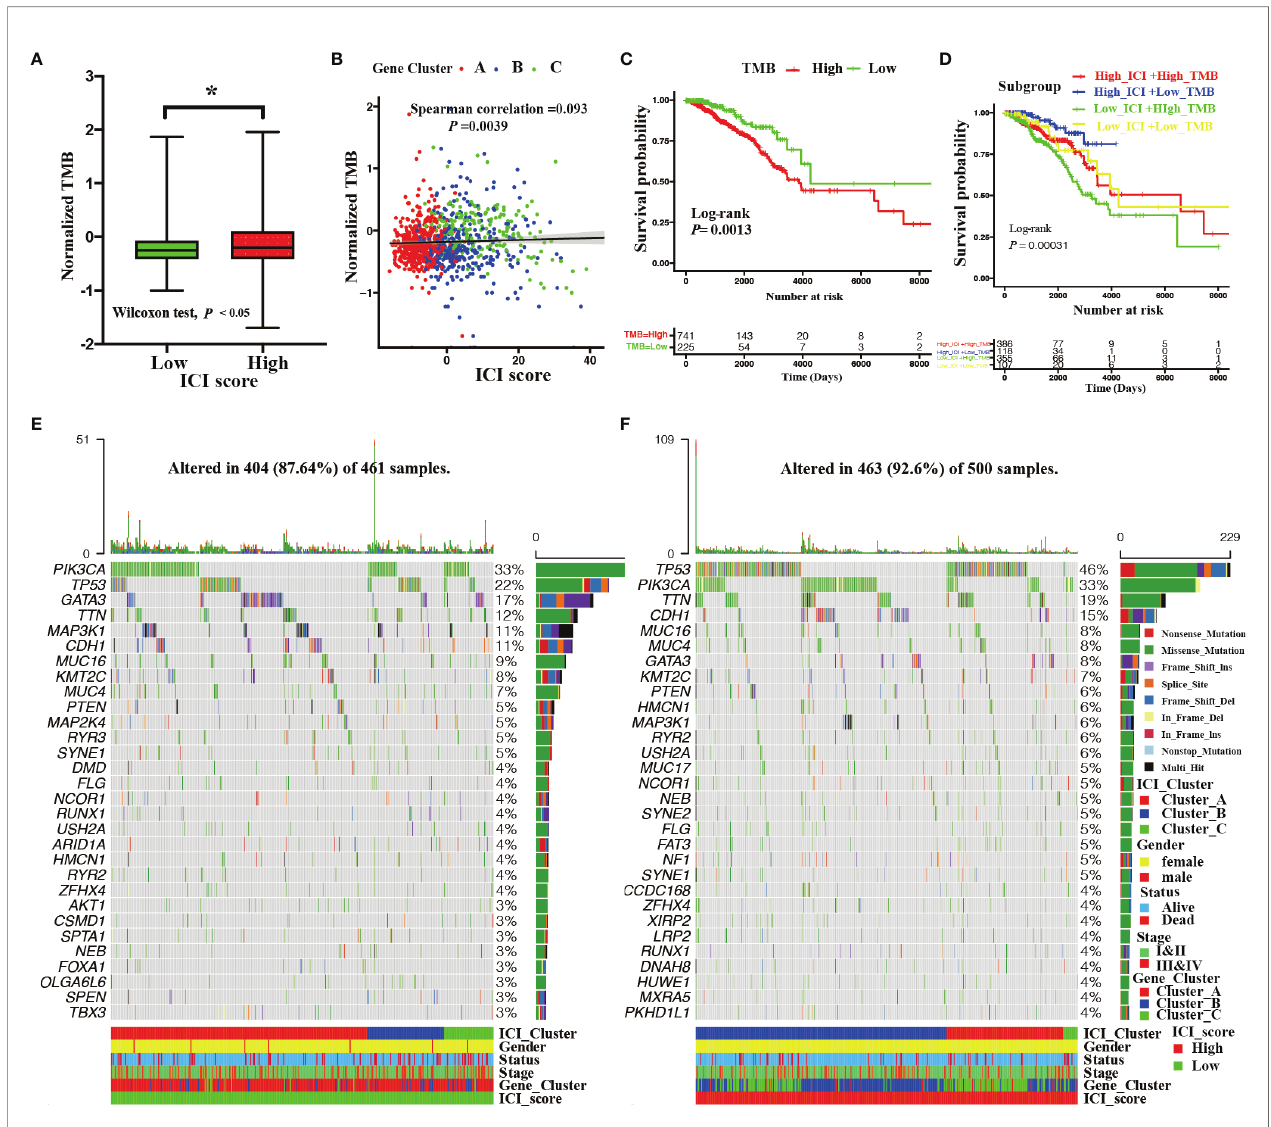
FIGURE 5 | Correlation between ICI score and somatic mutation. (A) The TMB among the high and low ICI score groups (Wilcoxon test, * P < 0.05). (B) Correlation between the ICI score and TMB with distinct gene clusters (Spearman correlation test, P = 0.0039; spearman correlation coef fi cient = 0.093). (C) Kaplan – Meier curves showing OS outcomes of BRCA patients between high and low TMB group. Log-rank test showing P = 0.0013. (D) Kaplan – Meier curves for BRCA patients strati fi ed by both TMB and ICI scores. Log-rank test showing P = 0.00031. (E, F) Landscape of the top 30 drive mutated genes for the low ICI score (E) and high ICI score groups (F) . Each column represents the individual patients and each row represents a drive mutated